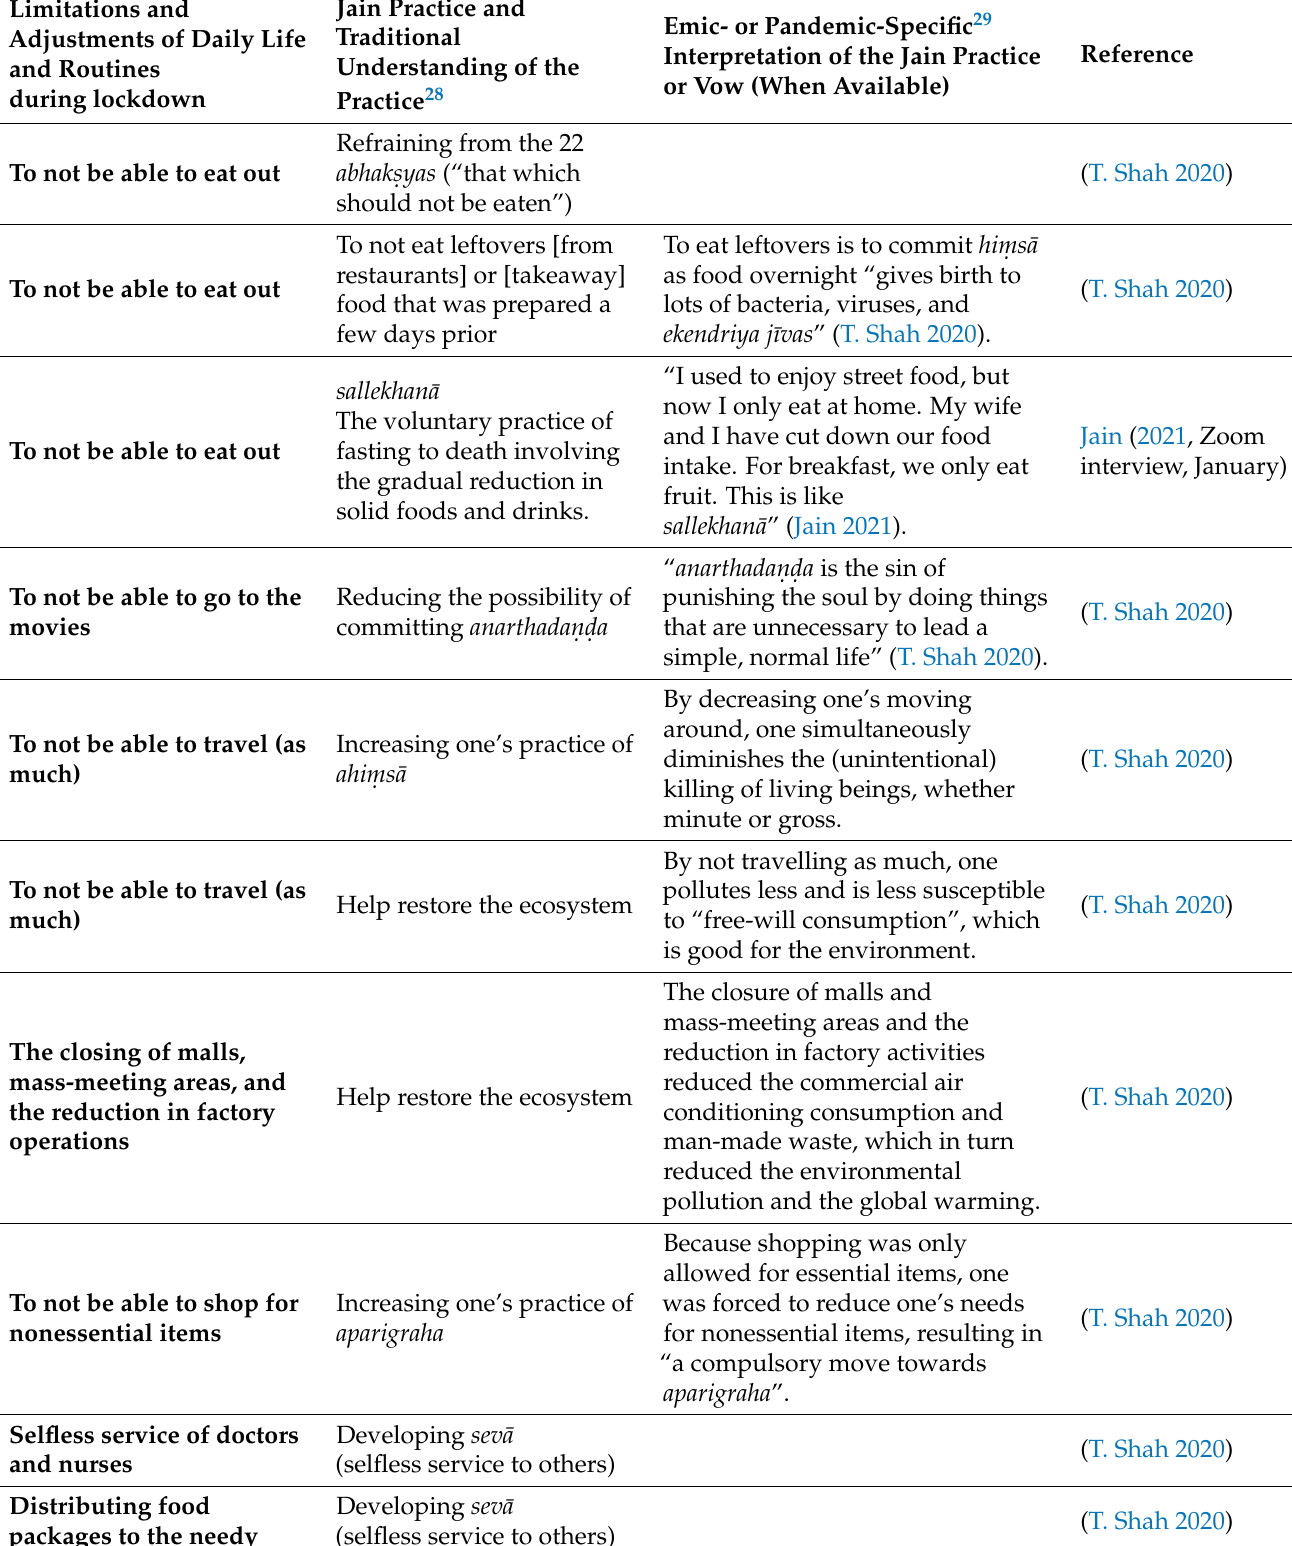
Table 3. Lockdown Restrictions and Jain